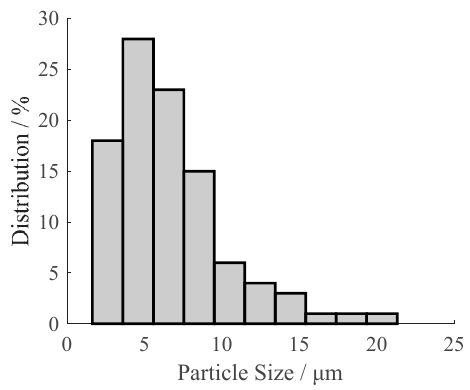
Figure 3. Particle distribution of the prepared oxygen scavenger in film. Materials 2020 , 13 , x FOR PEER REVIEW